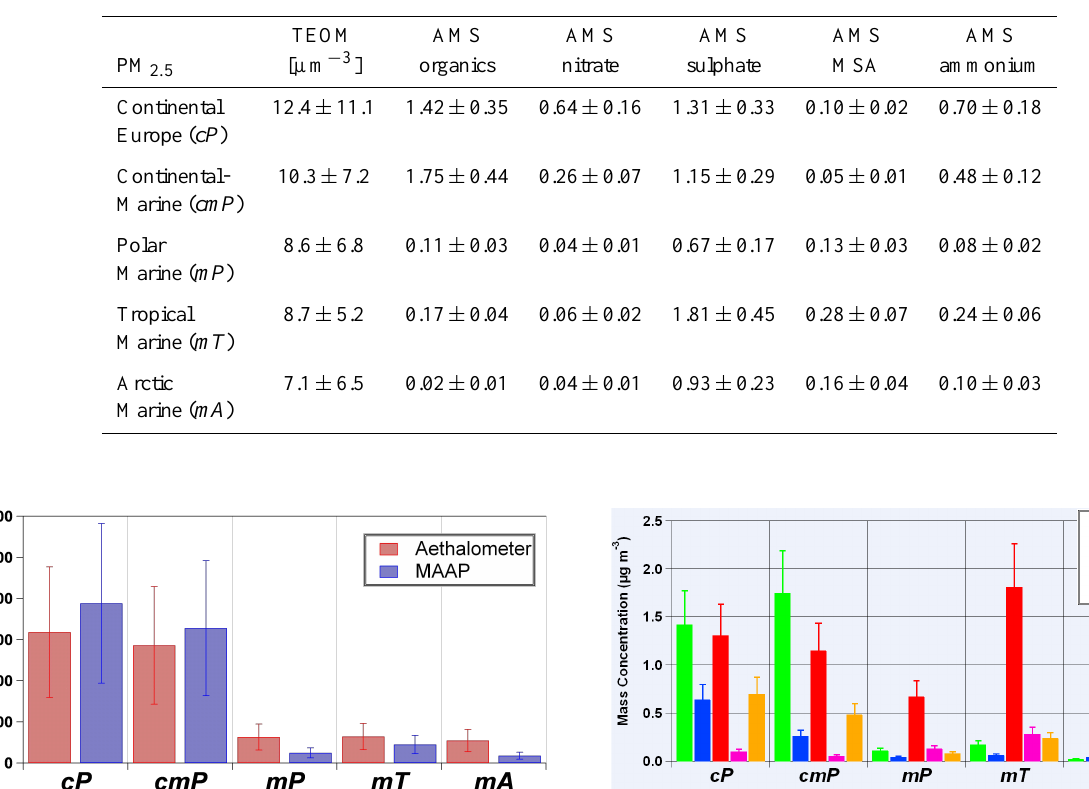
Table 3. PM mass and AMS derived sulphate, organic, MSA, nitrate and ammonium mass.